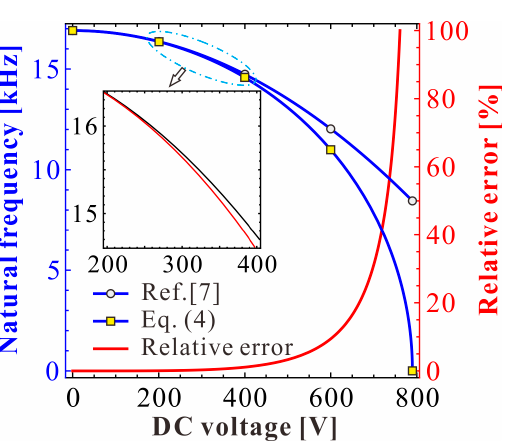
Figure 10. Dimensional comparison depicting the natural frequency versus DC voltage. Table 1. Geometric and material parameters of a MEMS resonator (refer to Reference [7]).